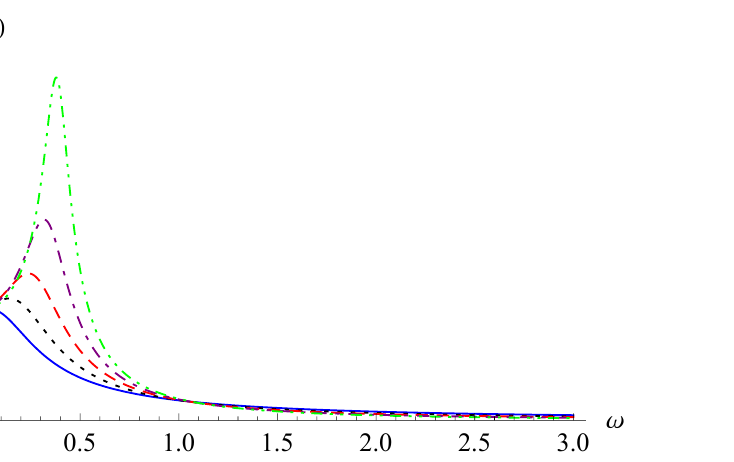
Figure 4. Frequency–amplitude curves for k = m = 1, c = 0.5, η = 5, and λ = 1.1 (solid line), 1.3 (dotted line), 1.5 (dashed line), 1.7 (dot-dashed line), or 1.9 (dot-dot-dashed line).